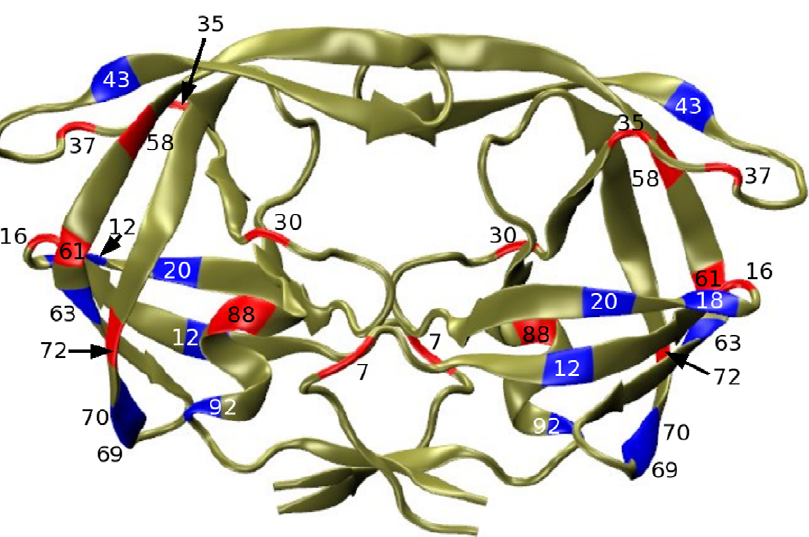
Figure 1. Structure of HIV protease subtype B. The backbone structure of HIV protease subtype B (PDB ID: 1NH0) is depicted in ribbon format. The 18 electrostatically active residues are highlighted. Residue positions which have a predominantly negatively charged non-neutral residue in the sequence database are depicted in red. Residues which have a predominantly positively charged non-neutral residue in the database are depicted in blue.